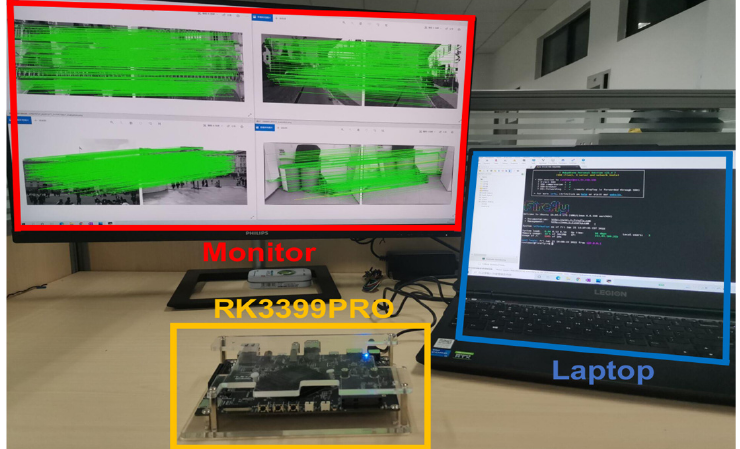
Figure 8. The whole system.